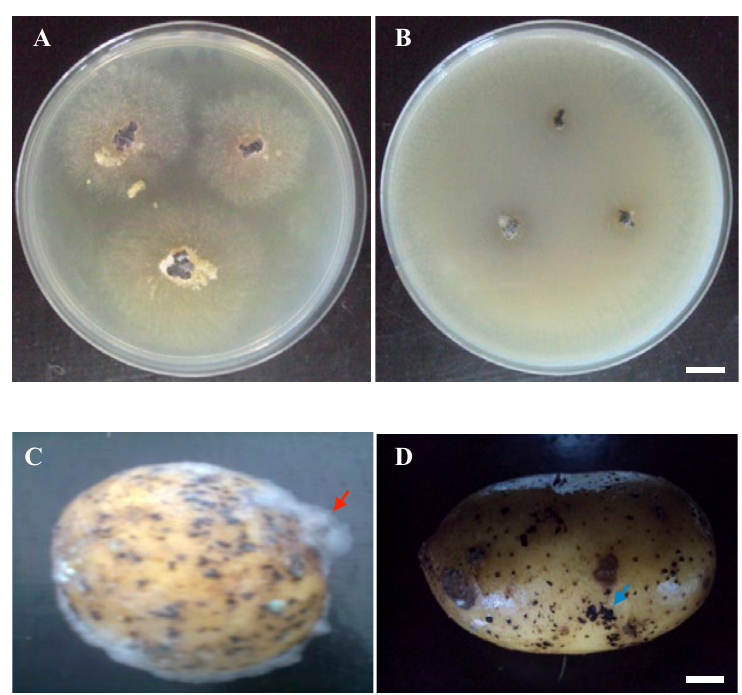
Figure 2. Effects of the strain RZ9 of Pseudomonas aeruginosa on Rhizoctonia solani mycelium emergence from detached sclerotia (A, B) and on mycelia development from infected potato tubers (C, D) incubated at 25°C. A, PDA medium show - ing mycelia growing from sclerotia; B, PDA medium mixed with RZ9 cell suspension ( c . 10 7 cfu ml -1 ) at 1% (v/v) showing growth inhibition of mycelium emergence from detached sclerotia; C, infected potato tuber sprayed with the LB medium showing the emergence of R. solani mycelium from sclerotia (Red arrow); D, infected potato tuber sprayed with P. aerugi- nosa strain RZ9 cell suspension grown in LB medium and showing the inhibition of R. solani mycelium development (Blue arrow). Bars = 1